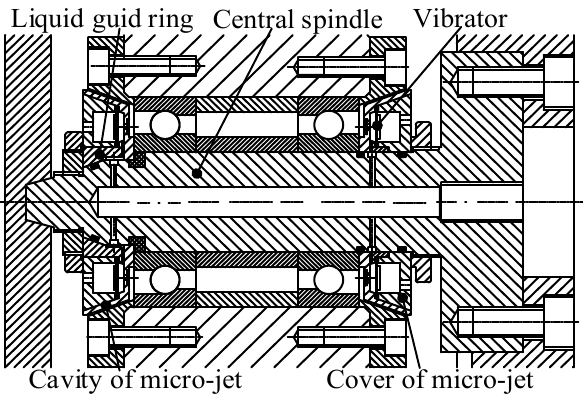
Figure 2. The local structure of gyroscope after embedding the piezoelectric micro-jets.